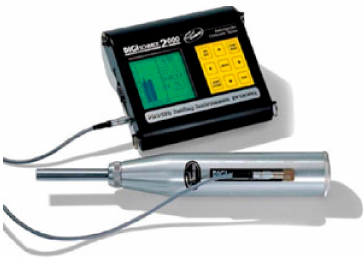
Figure 6. SCHMIDT rebound hammer test apparatus.